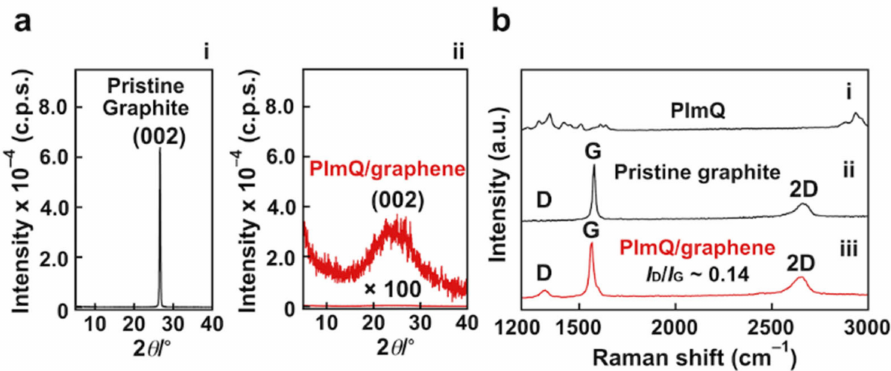
Figure 3. ( a ) XRD patterns of (i) pristine graphite and (ii) PImQ/graphene. ( b ) Raman spectra of (i) PImQ, (ii) pristine graphite, and (iii) PImQ/graphene. Excitation wavelength for Raman spectra: 633 nm.